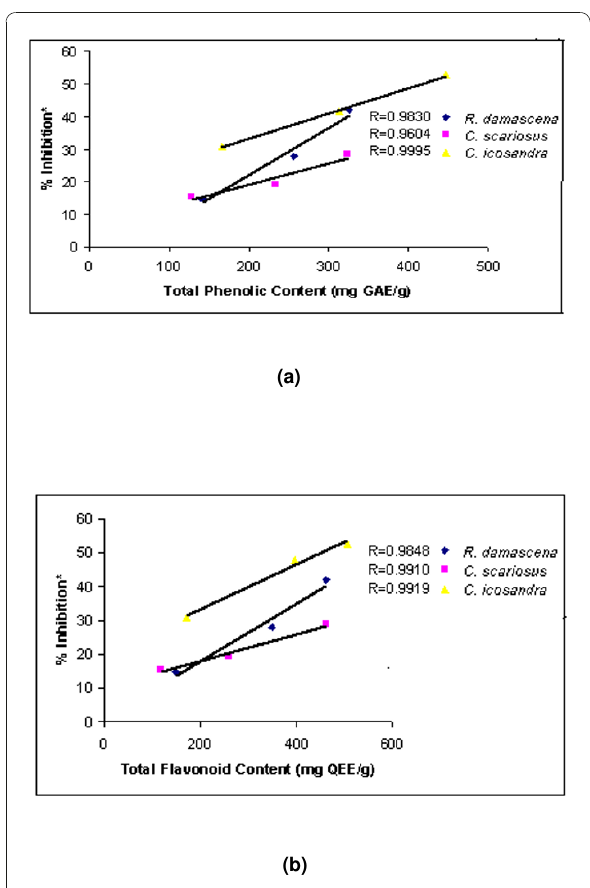
Figure 3 Correlation of % inhibition with Phenolic and Flavonoid contents . The relationship between (a) total phenolics content or (b) total flavonoid content in R. damascena , C. scariosus, C. icosandra and their antioxidant activity. The correlation analysis was described as linear correlation coefficient (R). The differences were considered statistically significant if p < 0.05.% Inhibition* = free radical scavenging activity as determined by ABTS assay.